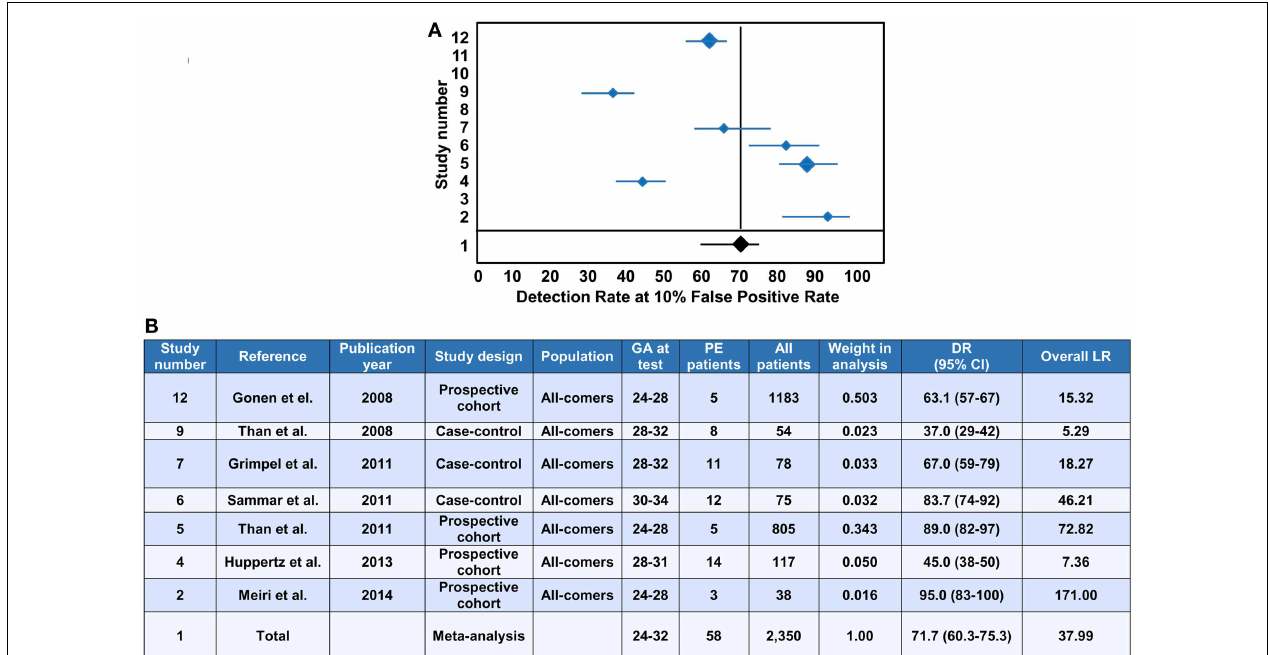
certain study in the analysis is reflected by the relative size of the diamonds. (B) The table lists studies used to perform the Forest plot for